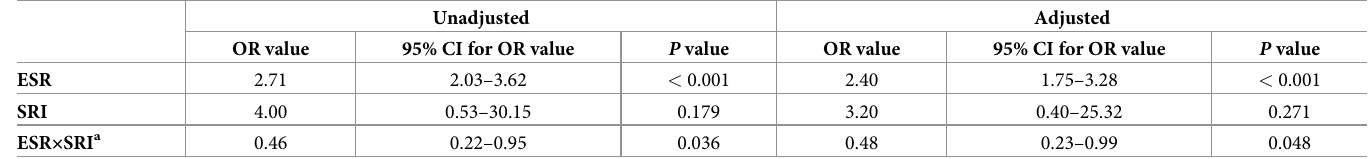
Table 3. Analysis of the interaction between ESR and SRI in diagnosis of